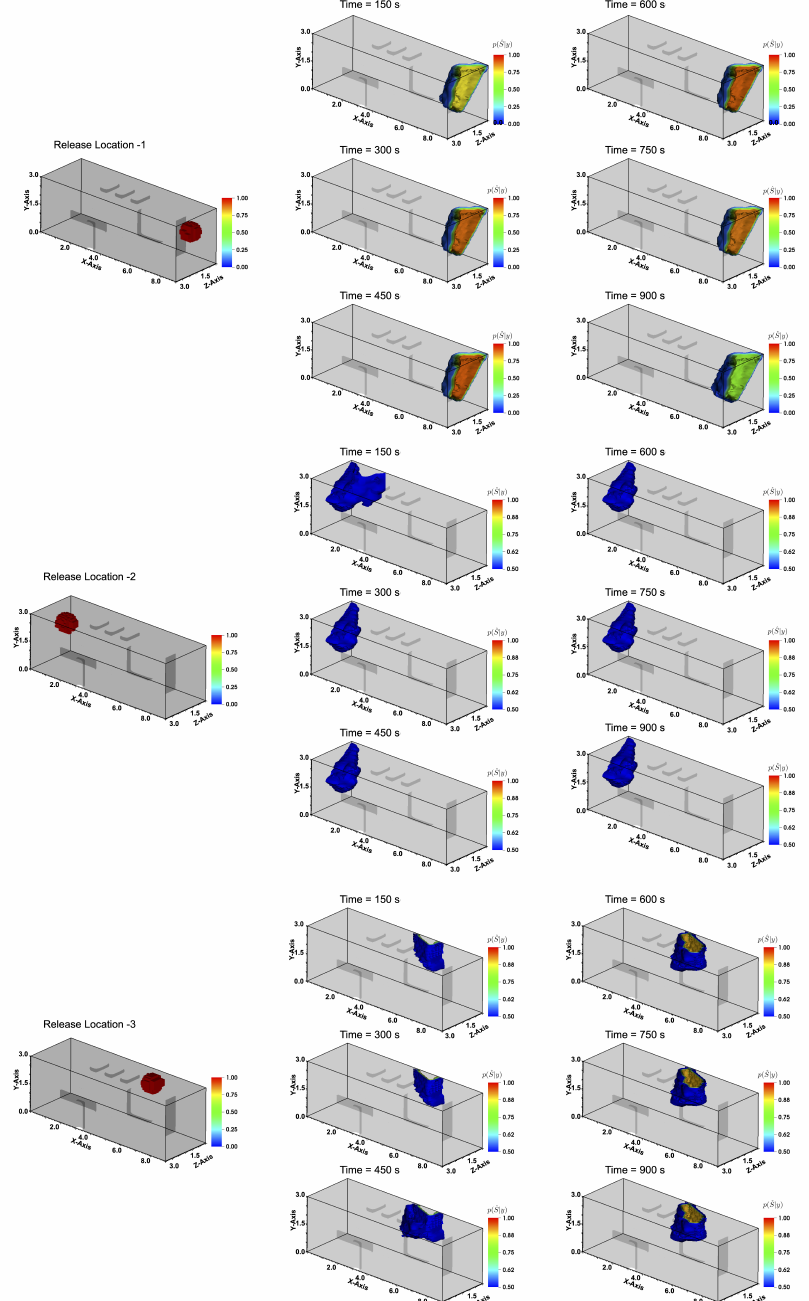
Figure 8. Bayesian inference Iso-Contours of the posterior for three random releases at every obser- vation time step in the three-dimensional room. The region of the release are shown in red color for each